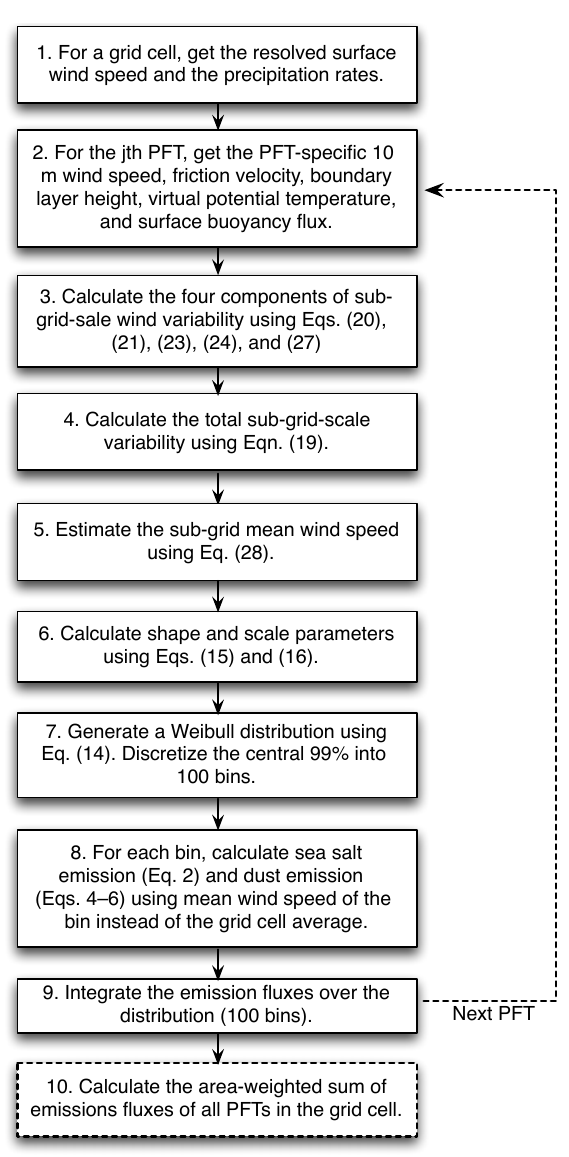
Figure 13. Flowchart illustrating the implementation of wind- distribution-based sub-grid emission calculations in CAM5. Dashed lines indicate steps that are only relevant for the dust emission cal-